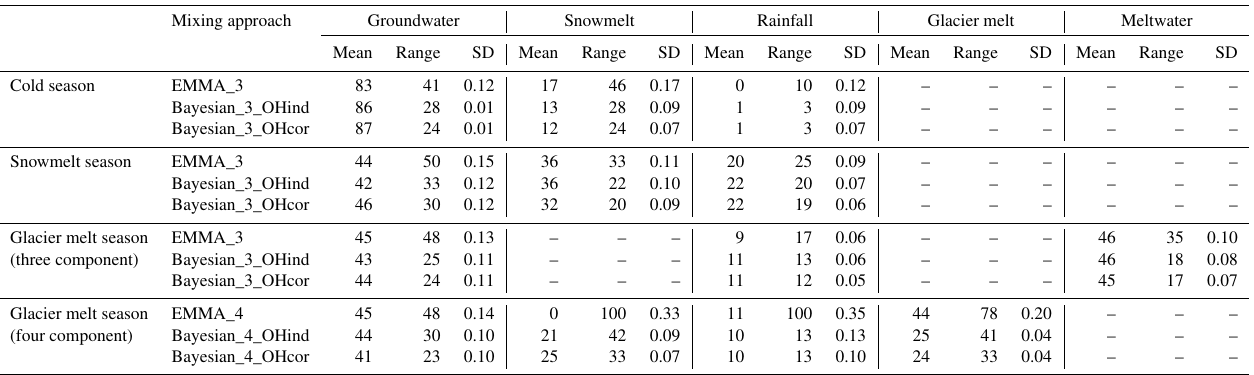
Figure 3. (a–i) Boxplots of tracer signatures in three seasons. (j–l) δ 18 O–EC mixing space of the various water sources in the three seasons. The solid lines indicate the ranges of tracer signatures measured from water samples. Table 4. Contributions of runoff components (CRCs) estimated by the different mixing approaches (percentage, %). The ranges (%) show the difference between the 95% and 5% percentiles. SD values refer to the standard